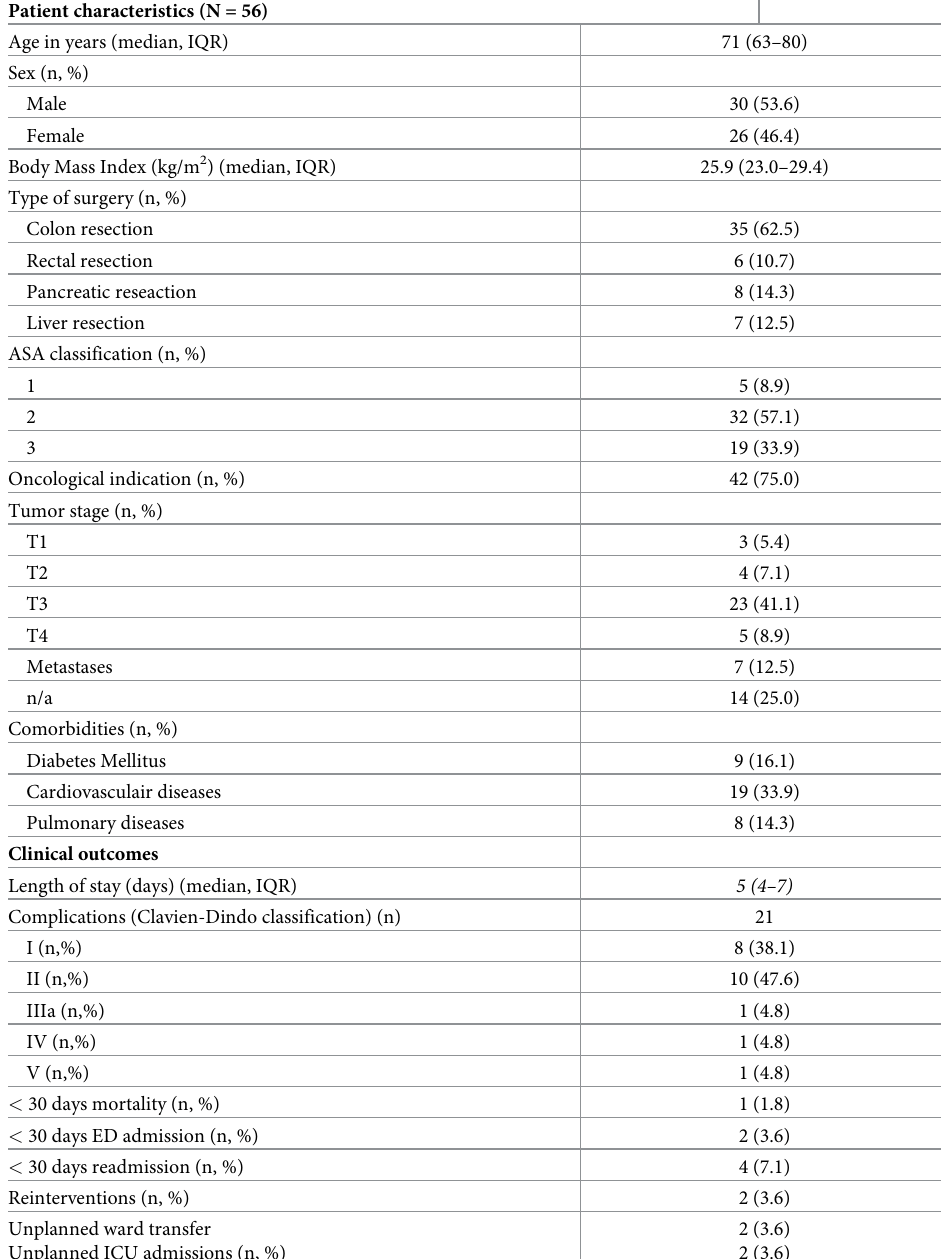
Table 1. Patient characteristics and